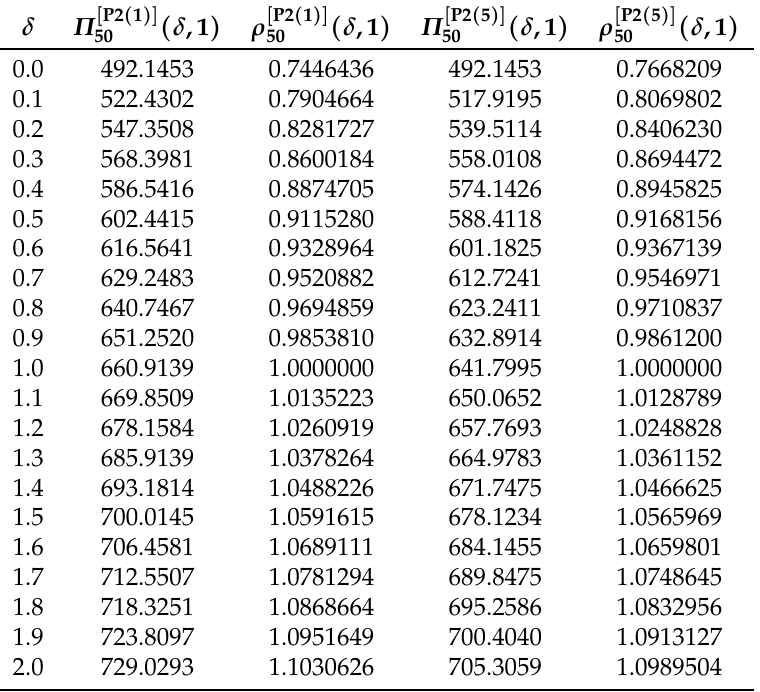
Table 10. Product P2 (acceleration benefit); x = 50, C = 1000.